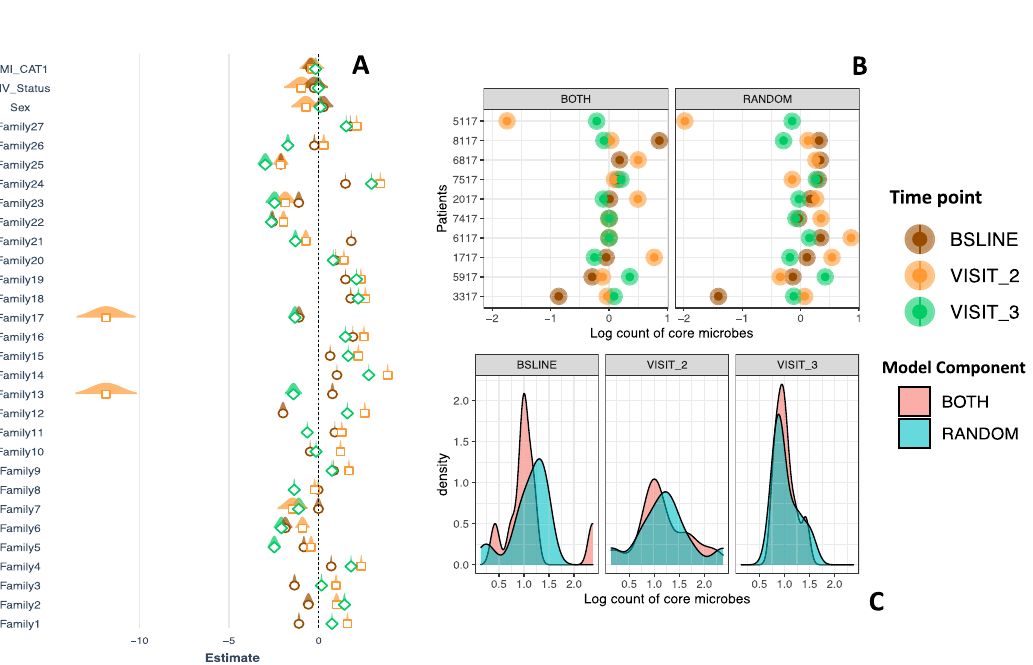
Figure 7. Analysis of microbial-abundance. ( A ) Depicts change in abundance across the treatment period accounting for BMI, HIV status and gender. Brown, orange and green depict months 0 (baseline), 2 and 3, respectively. ( B ) depict the variance attributed to an individual sample (random intercept of our mixed model) and that due to clinical variables (fixed component of the model), the latter was larger than the former, especially between months 0 (baseline) and 2 ( C ). This figure is based dataset C of Fig.